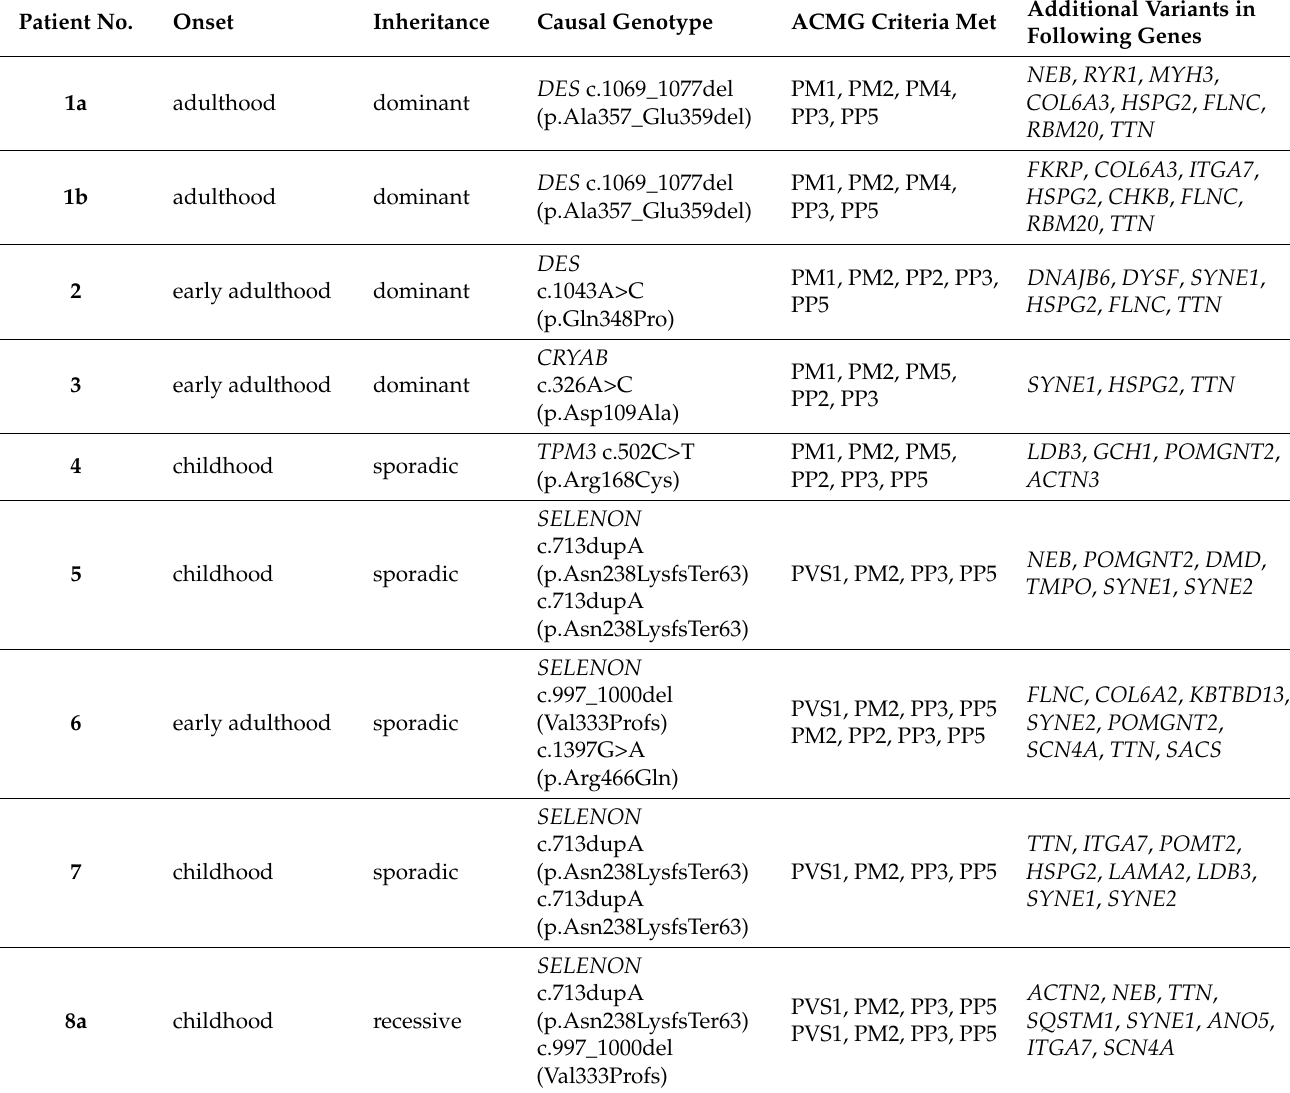
Table 2. Putative causative mutations and genes with potentially phenotype-influencing variants in MFM patients. Patient